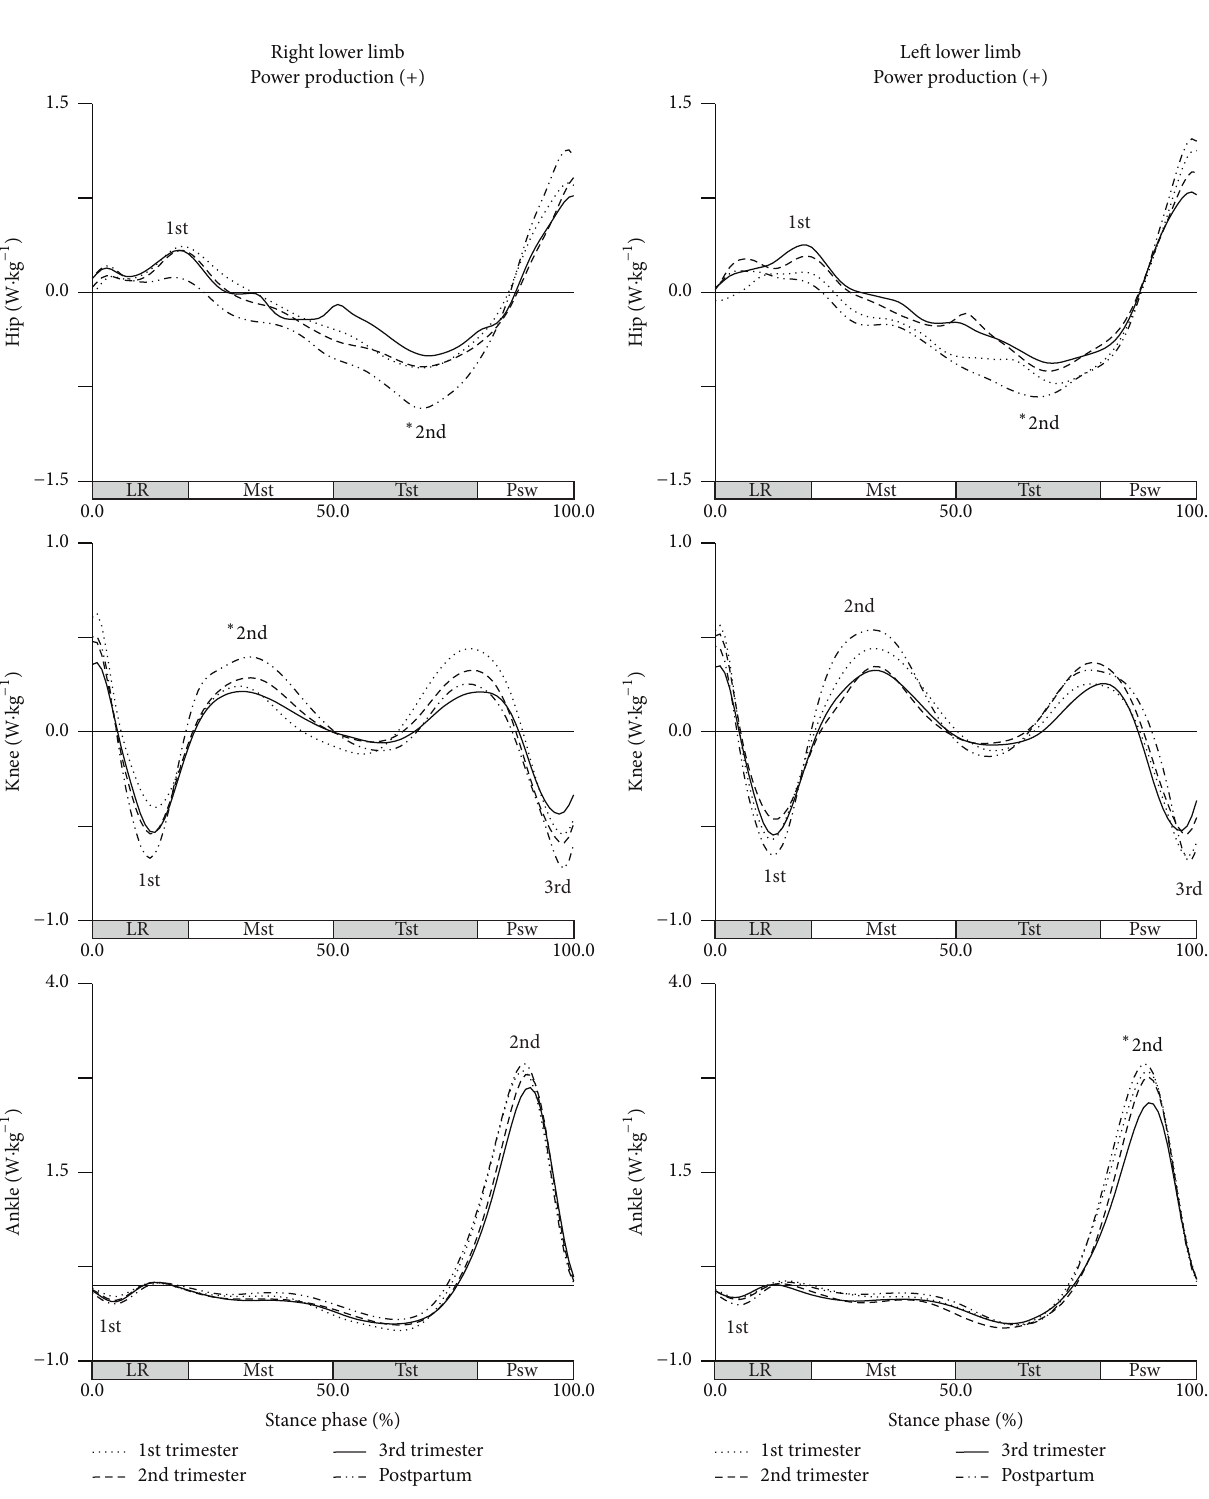
Figure 5: Joints power in the sagittal plane during gait (in W ⋅ kg −1 ). Each line represents the later stages of first (dotted line), second (dashed line), and third trimesters (solid line) and of postpartum period (dash-dot-dot line). Mean joint powers of the hip, knee, and ankle, for right and left lower limbs. The curve peaks are indicated by numbers: 1st, 2nd, and 3rd, and ( ∗ ) points the significant